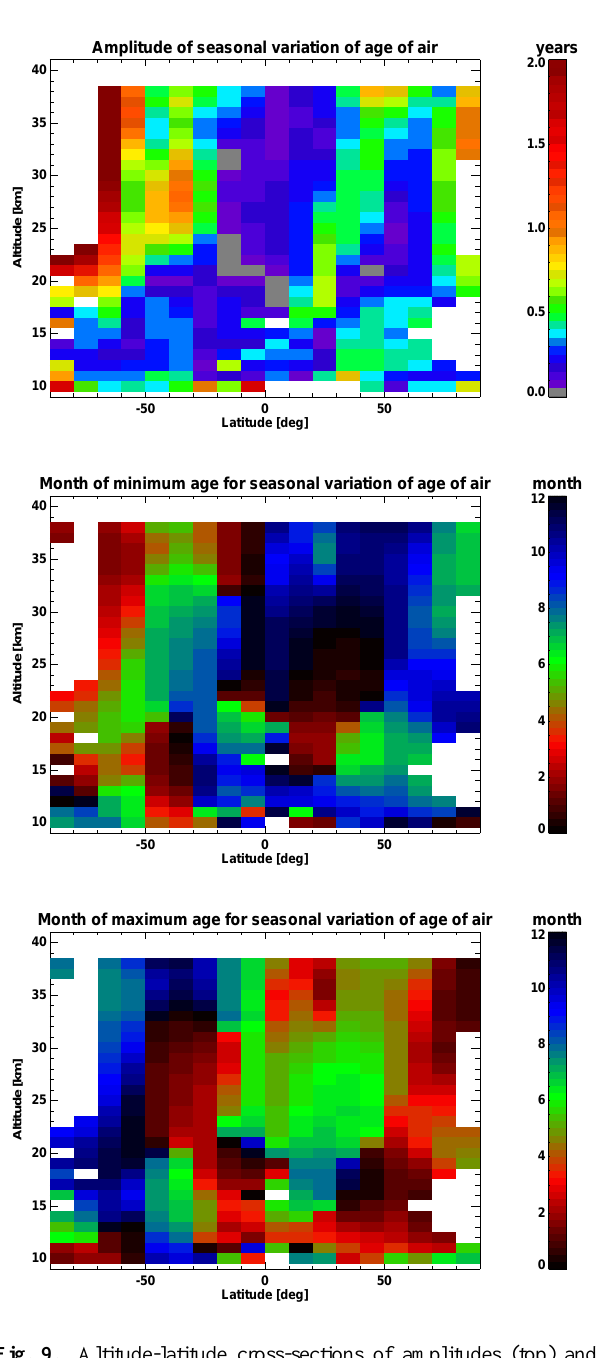
Fig. 9. Altitude-latitude cross-sections of amplitudes (top) and month of the minimum (middle) and maximum (bottom) of the seasonal variation of mean age of air.